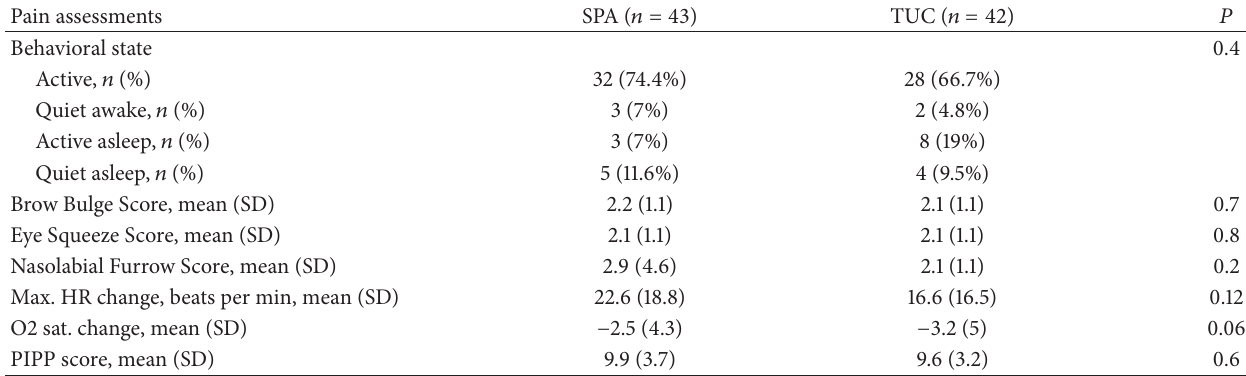
Table 2: Pain assessments in neonates during SPA and TUC using the PIPP.